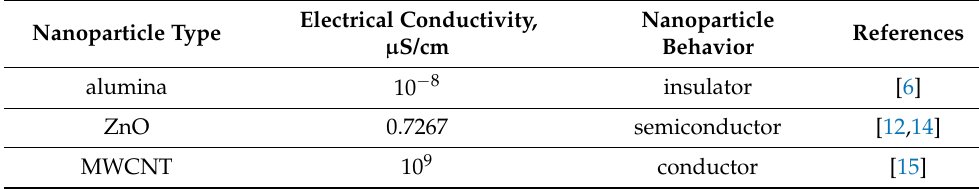
Table 3. Electrical conductivity of nanoparticles [6,12,14,15].